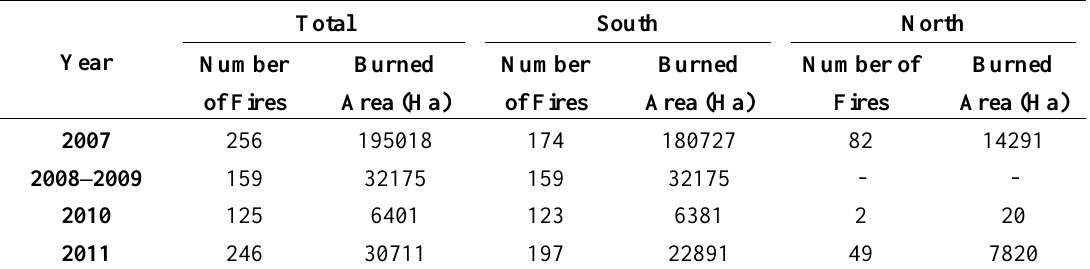
Table 3. Number of fires and burnt area in total, and separately for the Northern and Southern regions of